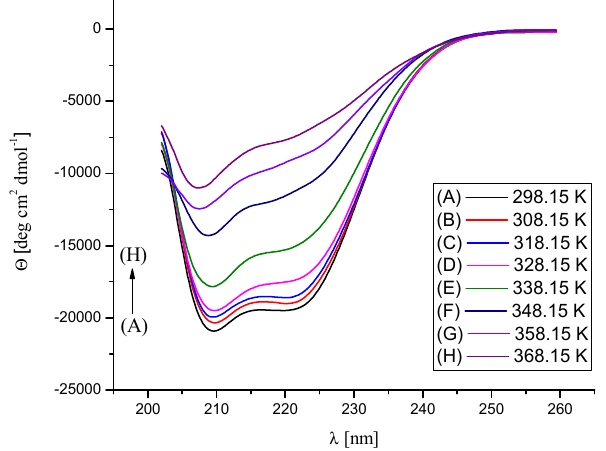
Figure 9. CD spectra of the Na[B(Ph) 4 ]/BSA mixture (Na[B(Ph) 4 ]:BSA = 2.5:1 molar ratio) in 10 mM Caco buffer at pH 7, in the temperature range 298.15–368.15 K. The concentration of BSA was maintained at 0.0015 mM.